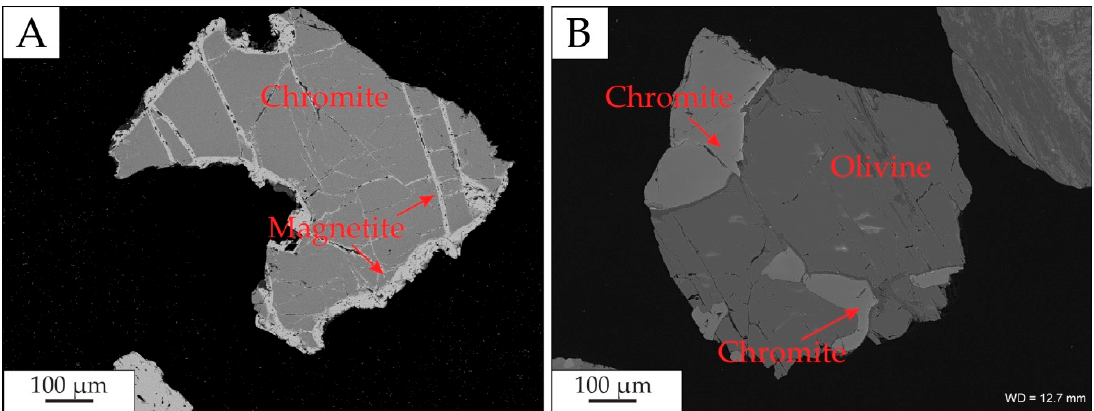
Figure 7. Chromite paragenesis with magnetite. SEM-BSE (Scanning Electron Microscopy-Backscattered Figure7. Chromiteparagenesiswithmagnetite. SEM-BSE(ScanningElectronMicroscopy-Backscattered Electron Mode) image. (A) single grain with magnetite, (B) olivine grain with chromite. Electron Mode) image. ( A ) single grain with magnetite, ( B ) olivine grain with